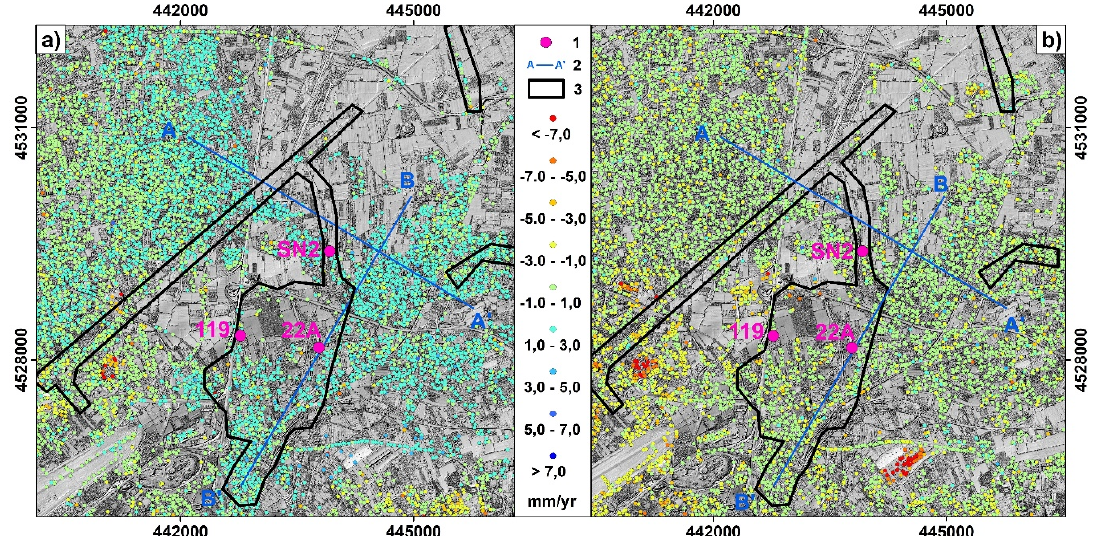
Figure 5. Line of Sight (LoS) velocity maps (mm / yr) of the study area by ERS1 / 2 ( a ) and ENVISAT ( b ) data. Legend: 1) long-term monitoring well; 2) trace of hydrostratigraphic cross-section; 3) wells field area. Table 1. Differential Interferometry SAR ( DInSAR) LoS measurement statistics referred to the whole area.